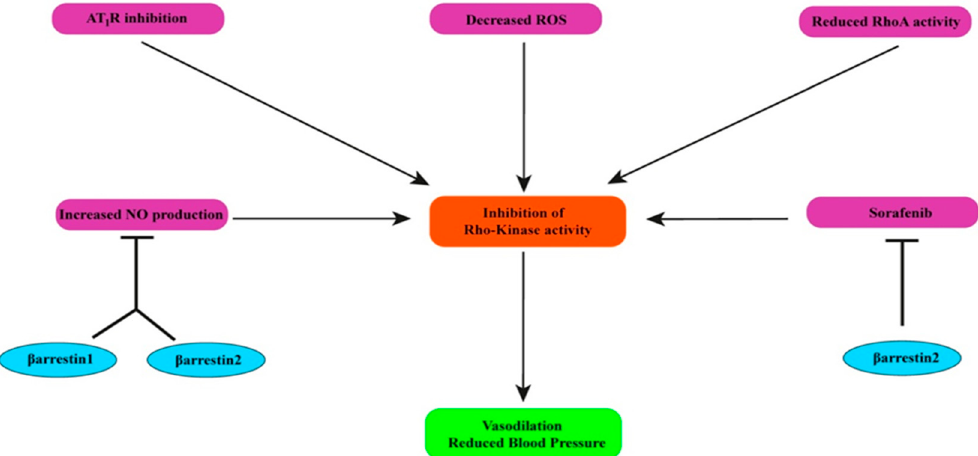
Figure 6. Inhibiting ROCK activity causes vasodilation, leading to blood pressure reduction. ROCK inhibition is mediated by declined RhoA activity, specific AT1R inhibition, a decreased amount of ROS, and increased NO production. However, both β -arrestin1 and β -arrestin2 are associated with decreasing the amount of NO. Moreover, β -arrestin2 impedes the activity of sorafenib, a ROCK inhibitor.